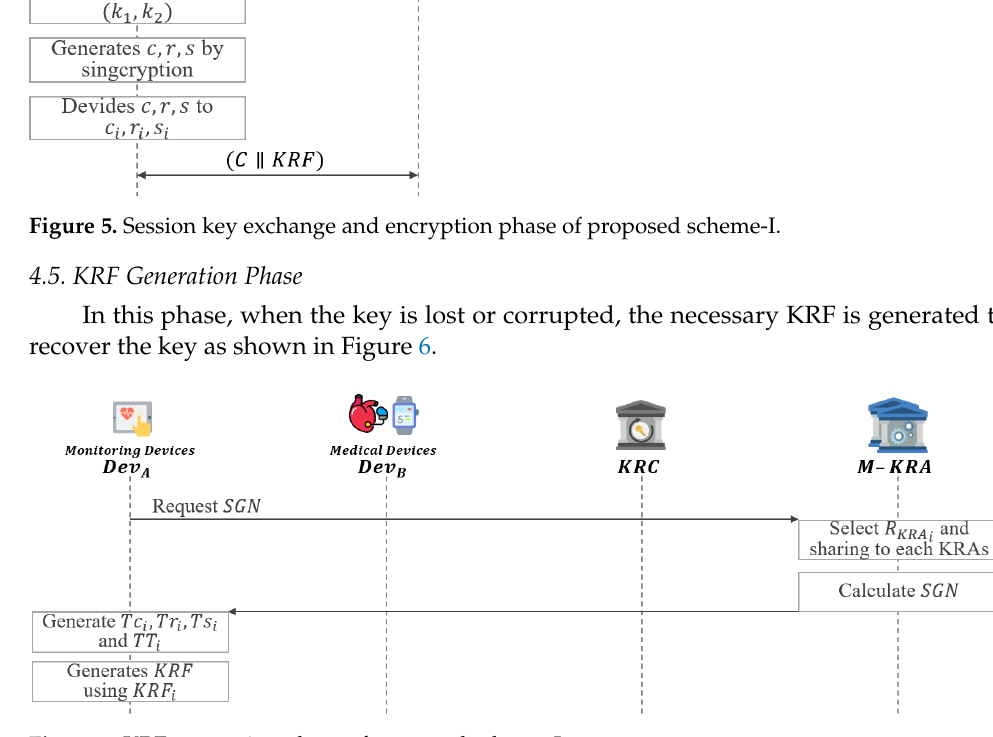
Figure 6. KRF generation phase of proposed